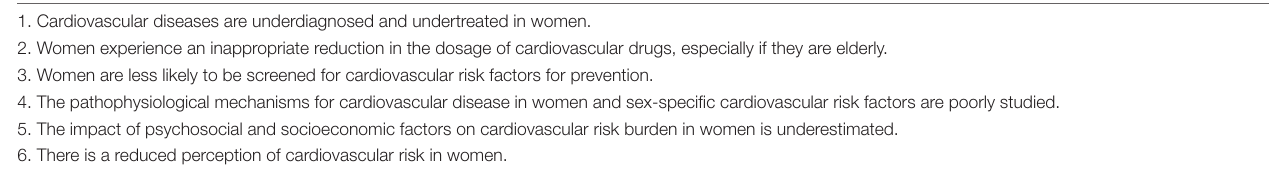
TABLE 1 | Gender differences in the cardiovascular field that could be corrected by teaching gender